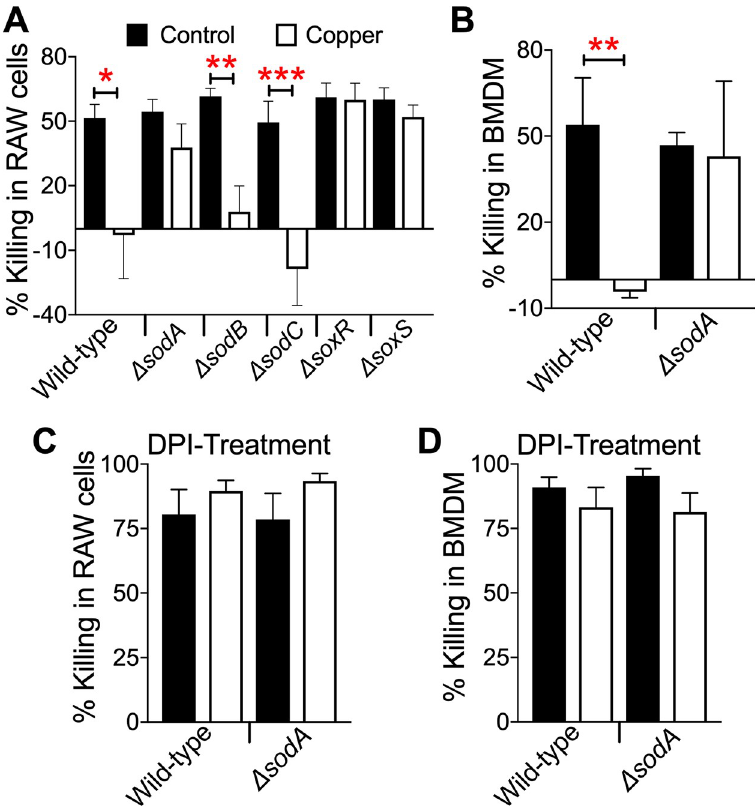
Fig 8. UPEC sodA mediates copper-dependent protection from killing within macrophages. (A) RAW264.7 murine macrophages were infected with copper-exposed or control wild-type strain CFT073, and Δ sodA , Δ sodB , Δ sodC , Δ soxR , or Δ soxS mutants. Extracellular bacteria were killed with gentamicin. E . coli internalization, and survival within macrophages was determined by viable counts. Bacterial counts were normalized to protein content, and percent killing was calculated. (B) Percent killing of copper-exposed or control wild-type, and Δ sodA mutant strains in murine bone marrow-derived macrophages (BMDM). Percent bacterial killing in RAW cells (C) and BMDMs (D) treated with diphenyleneiodonium (DPI, 20 μ M), an inhibitor of NADPH oxidase. Bars depict mean + SEM from 3–6 independent experiments, conducted in triplicate. � P < 0 . 05 , �� P < 0 . 01 , ��� P < 0 . 001 , ANOVA with Bonferroni’s multiple comparisons